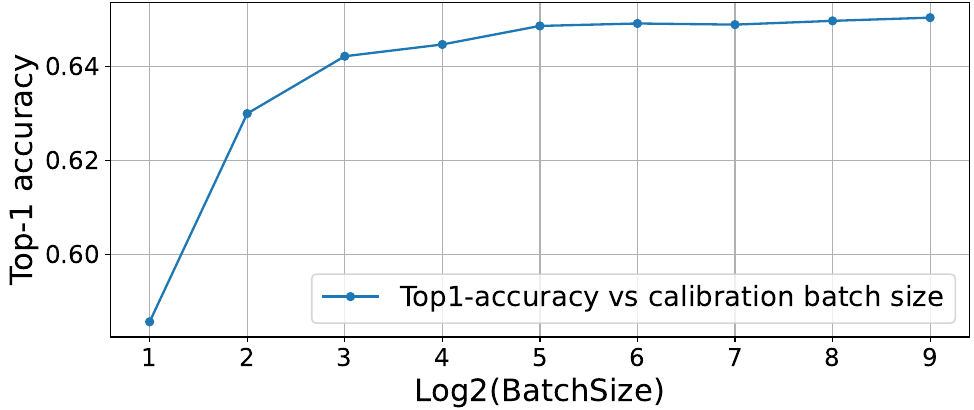
Figure A4. Top-1 accuracy of the post-calibration model vs. the calibration batch size